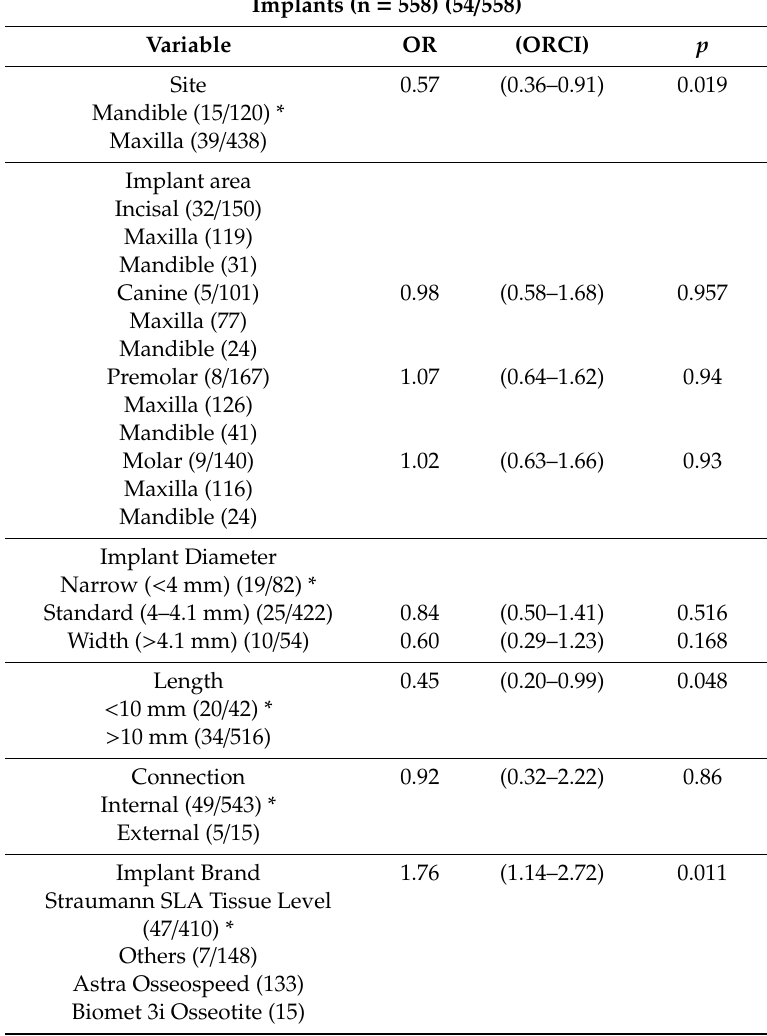
Total of mucositis complications = 54.